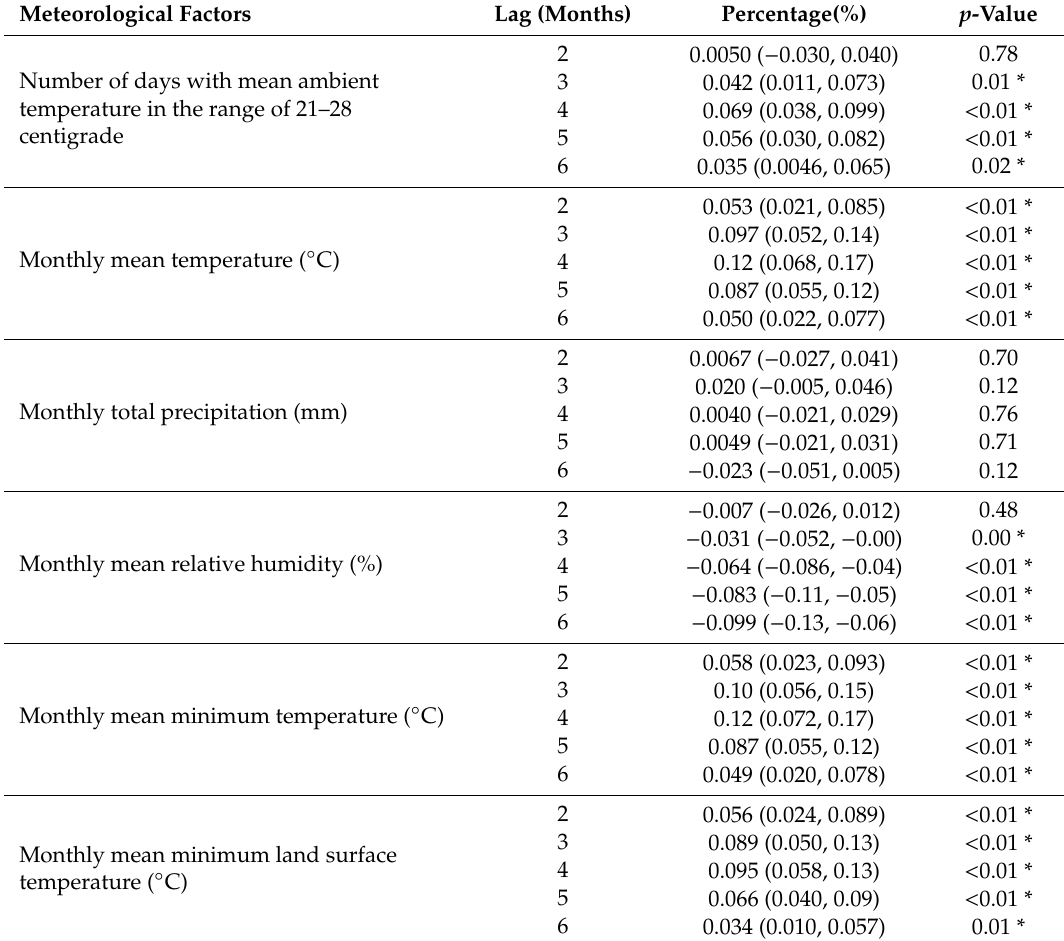
Table 2. Percent change of VL events associated per unit increase of meteorological factors from single-variable